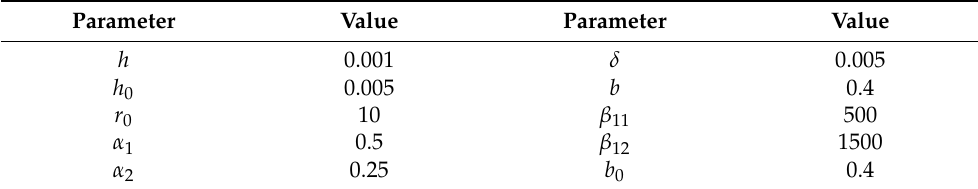
Table 3. ADRC Controller parameters.